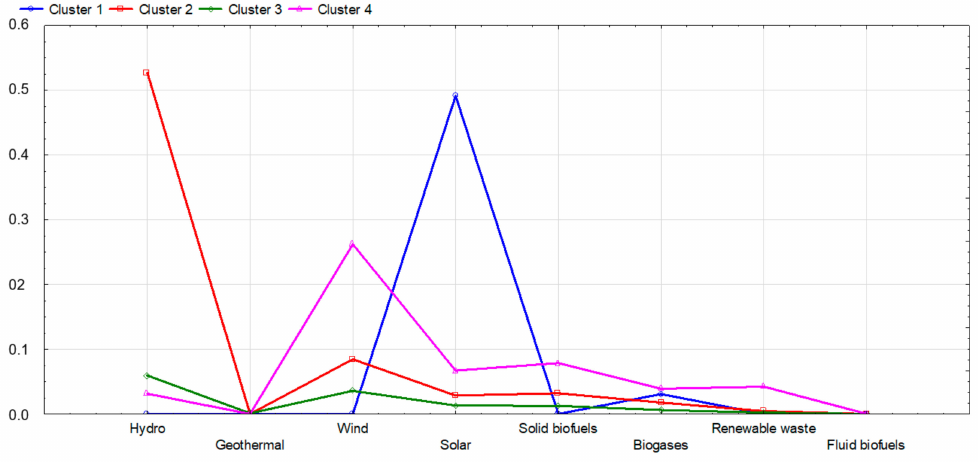
Figure 17. Mean values of energy production from renewable energy sources in relation to the area of selected countries for individual clusters (own